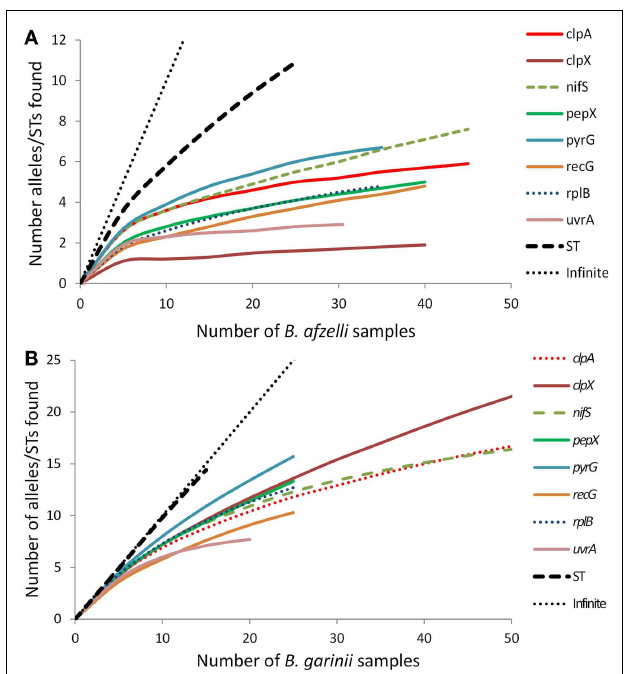
FIGURE 1 | Rarefaction curves for each of the eight B . burgdorferi s.l. loci and sequence types (STs) of (A) B. afzelii samples and (B) B. garinii samples analyzed from Scotland . Each graph also includes the 45° line (labeled “infinite”) which represents the trajectory that would occur if every new allele or sequence type found was new. FIGURE 2 | Distribution and relative abundance of B . burgdorferi s.l.